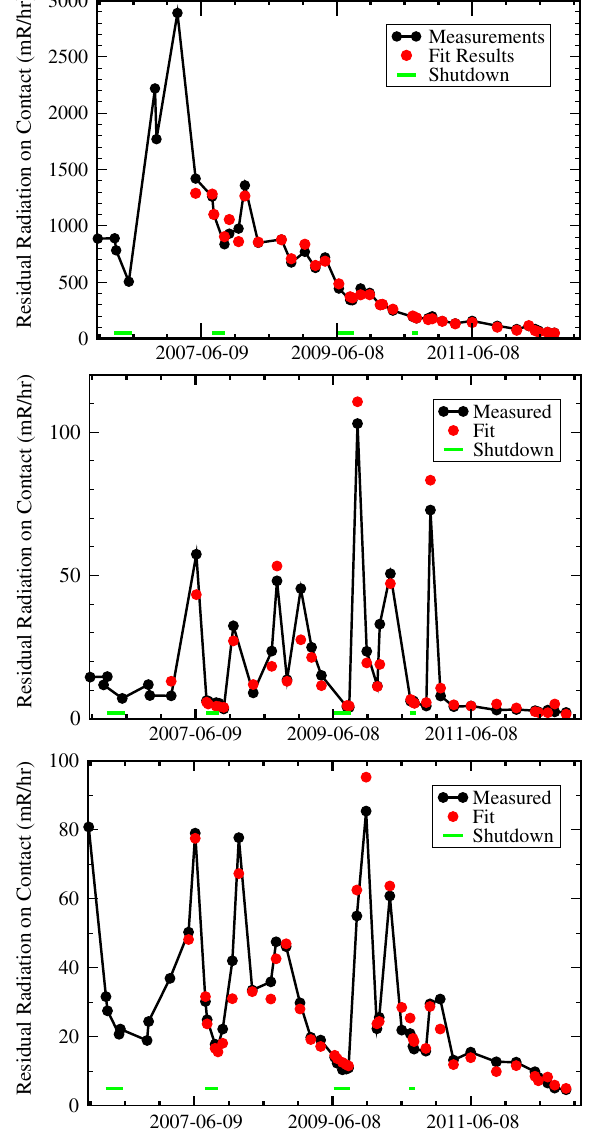
FIG. 14. Residual Radiation History at barcoded locations fitted to BLM loss weighted by set of isotope half lives. LAM522 fit to LI522A loss (top), Top of Q104 Downstream End fitted to LI104 loss (center) and Top of Sextupole S408 fitted to LI408 loss (bottom). Reduced loss at Q104DS followed commissioning of Gap Clearing